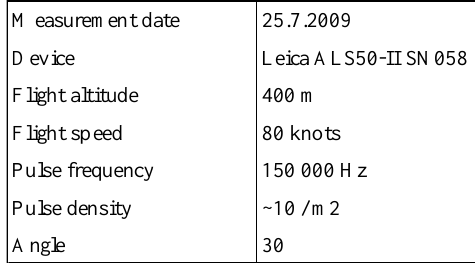
Table 2. ALS acquisition parameters.